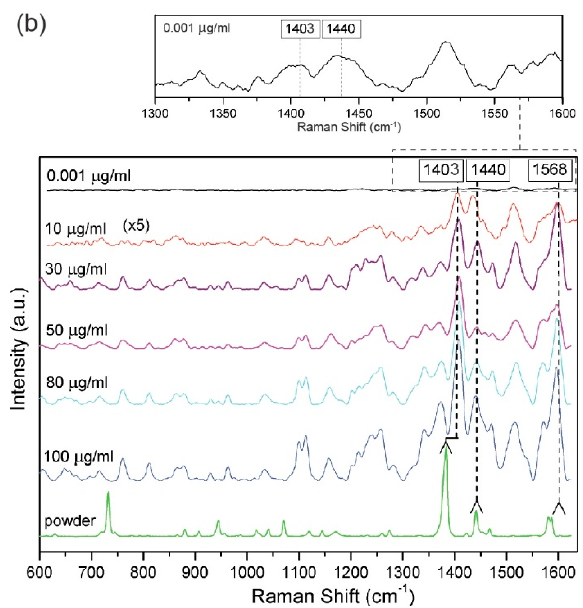
Figure 6. The averaged selected SERS spectra of Thiram ( a ) and Carbaryl ( b ) pesticides, measured in five different places of PET/ITO/Ag platforms. The Raman spectra of pesticides powder are presented on the bottom of each figures. The main Raman bands are indicated by dashed lines. Three accumulation for four seconds of SERS spectra were recorded using a 785 nm laser excitation (the laser power was below 5 mW). Table 1. The band assignments of major peaks in SERS spectra for Thiran and Carbaryl [11,49].